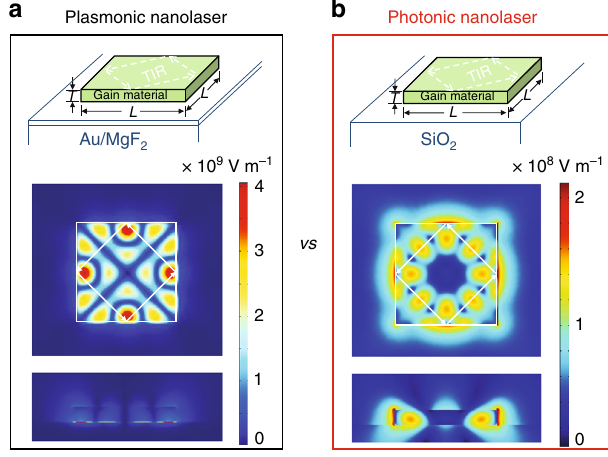
Fig. 1 Schematic of plasmonic and photonic lasers and their cavity modes. a Top: schematic of the plasmonic nanolaser devices consisting of a nanosquare gain material on top of metal separated by a few nanometers of dielectric. Bottom: top and side views of electric fi eld ( | E | ) pro fi les of a cavity mode in a 700 × 700 × 100 nm plasmonic cavity. b Top: schematic of the photonic nanolaser devices consisting of a nanosquare gain material on top of dielectric. Bottom: top and side views of electric fi eld ( | E | ) pro fi les of a cavity mode in a 700 × 700 × 100 nm photonic cavity. In both panels, L and T are the length and thickness of the nanosquare, respectively, and TIR represents total internal re fl